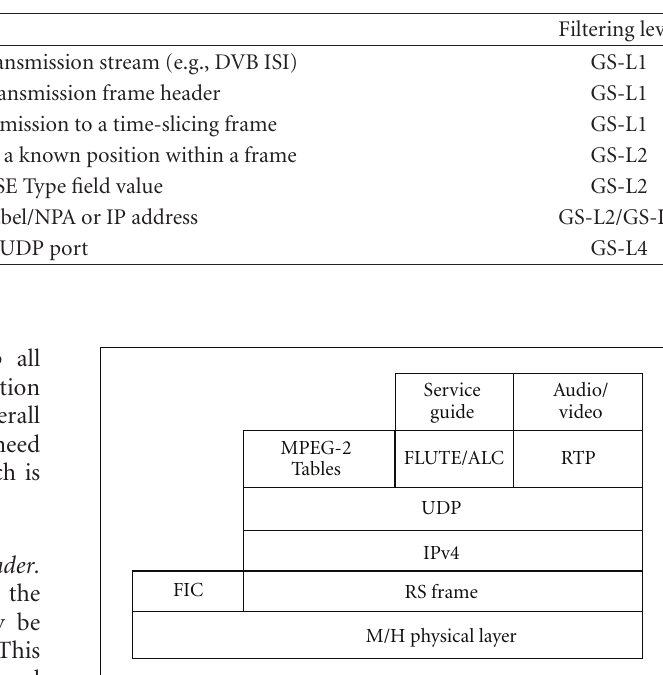
Table 2: Candidate methods for identifying GSE packets carrying network signalling.